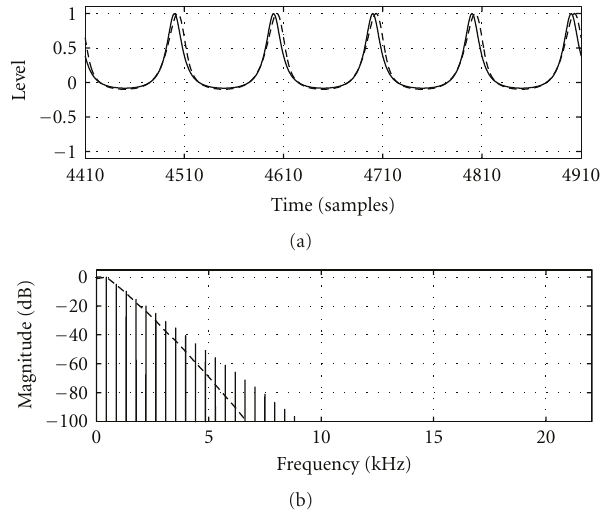
Figure 17: FBAM variation 5 ( β = 0 . 85, f 0 = 441Hz) with feedback period D = 100 (solid), see Figure 10(f). The dashed line plots the basic FBAM with period D =